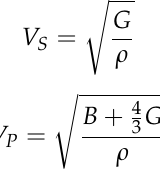
Figure 2. ( a ). Theoretical prediction of elastic constants ( C ij ) for cubic Zr 0.5 Nb 0.5 as a function of pres-